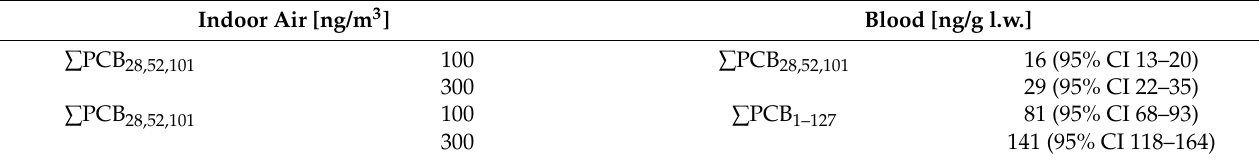
Table 3. Blood burden of ∑ PCB 28,52,101 and ∑ PCB 1–127 (ng/g l.w.) due to exposure to ∑ PCB 28,52,101 in indoor air (ng/m 3 ).